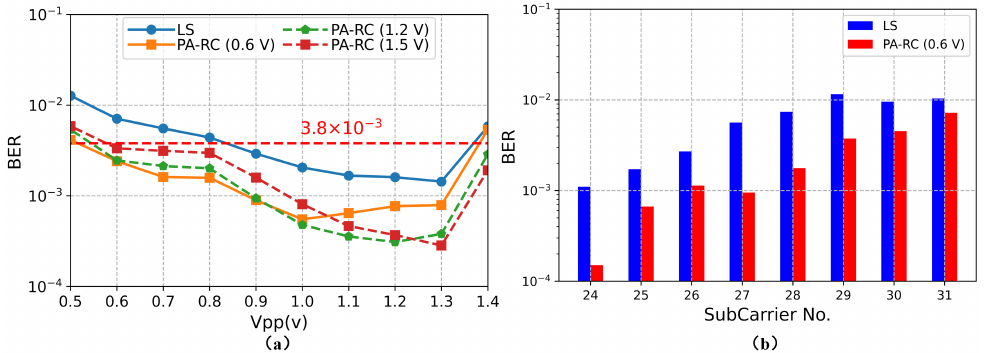
Figure 8. The data rate is 240 Mbps: ( a ) BER vs. Vpp; ( b ) BER vs. Subcarrier number when Vpp is 1.2